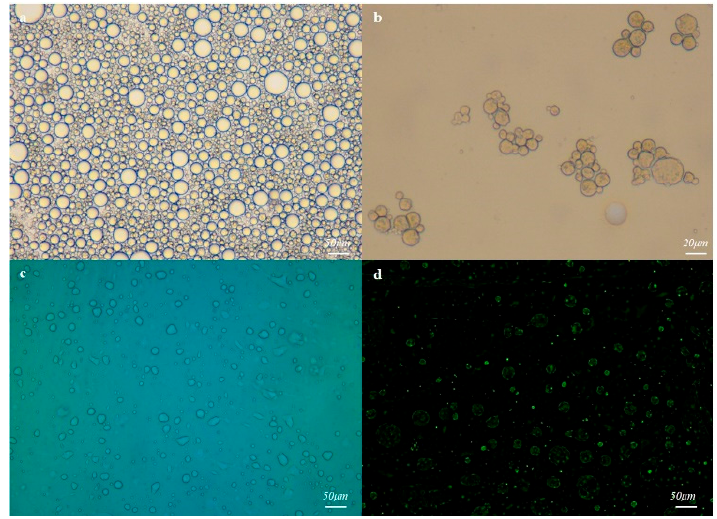
Figure 4. High-resolution microscopy of the W/O emulsion droplet reactor ( a ), micrographs after polymerization ( b ), fluorescence micrographs of FITC-labeled MMHSs under brightfield ( c ), and under darkfield ( d ).